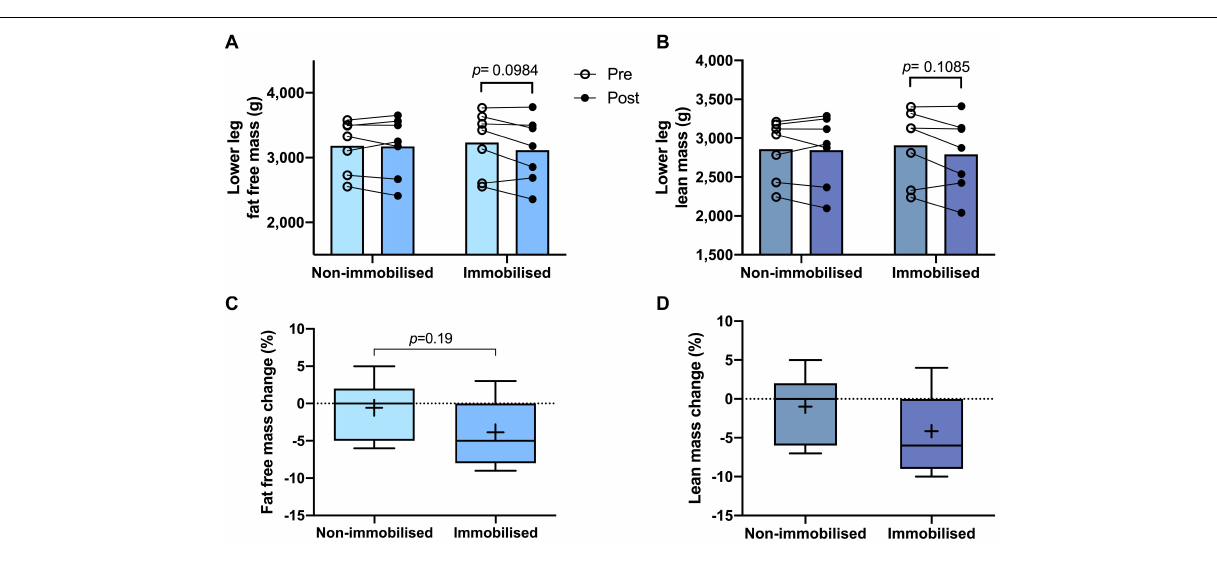
FIGURE 3 | Pre and post 15 day unilateral leg immobilisation lower leg fat free mass (A) and lean mass (B) in non-immobilised and immobilised legs. Corresponding percentage changes in fat free mass (C) and lean mass (D) . Mean values are denoted as +, with box margins the 25th and 75th percentile and whiskers min to max values. Pre and post analysis measured by 2-way ANOVA, percentage change by paired t